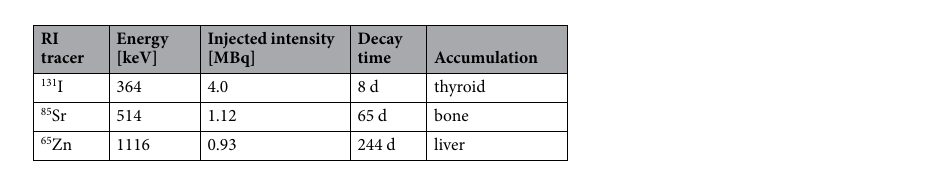
Table 1. Features of radioactive tracers in mouse